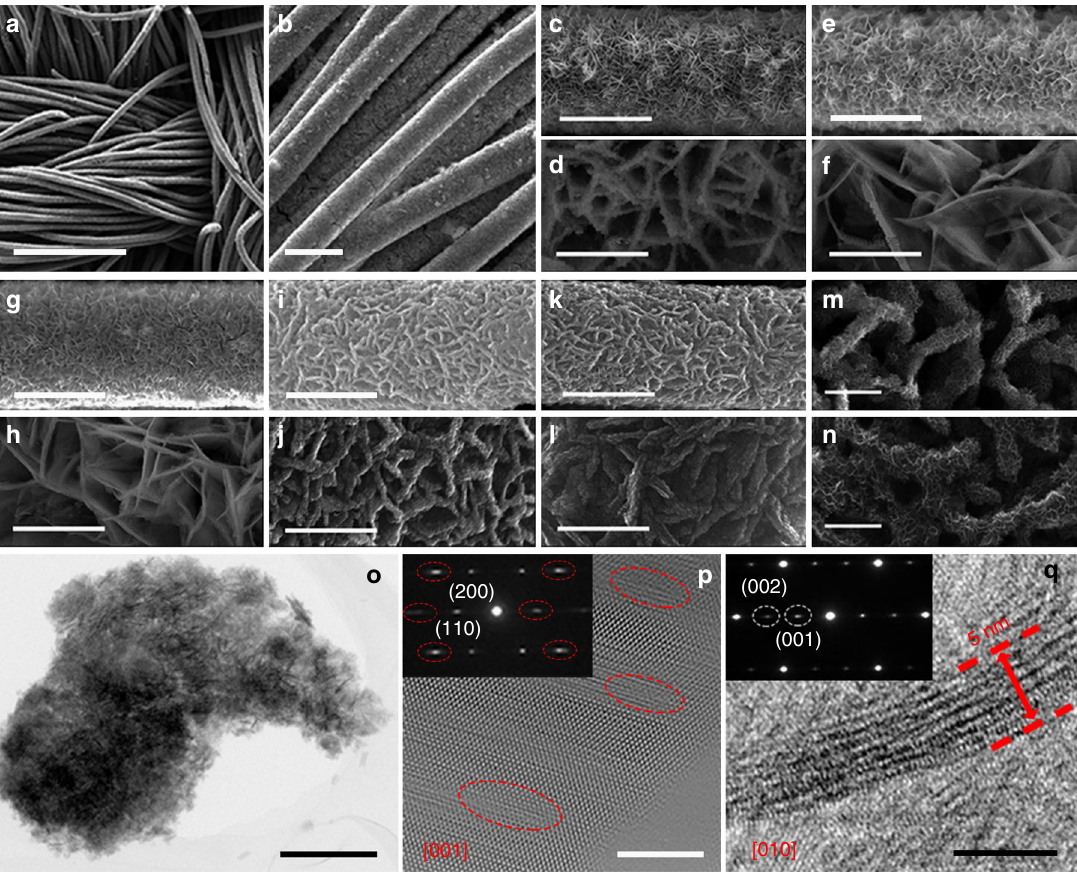
Fig. 2 FESEM and TEM images. a , b , k , l , n FESEM images of the S4 sample. c , d FESEM images of the Mn 3 O 4 nanowall arrays. e , f FESEM image of the S1 sample. g , h FESEM image of the S2 sample. i , j , m FESEM images of the S3 sample. o TEM image for the S4 sample. p HRTEM image for the S4 sample along [001] zone axis. Inset in p is the SAED pattern along [001] zone axis. q HRTEM image for S4 sample along [010] zone axis. Inset in q is the SAED pattern along [010] zone axis. a Scale bar, 150 μ m. b Scale bar, 20 μ m. c , e , g , i , k Scale bar, 10 μ m. d , f , h , j , l Scale bar, 2 μ m. m , n Scale bar, 500 nm. o Scale bar, 300 nm. p , q Scale bar, 5